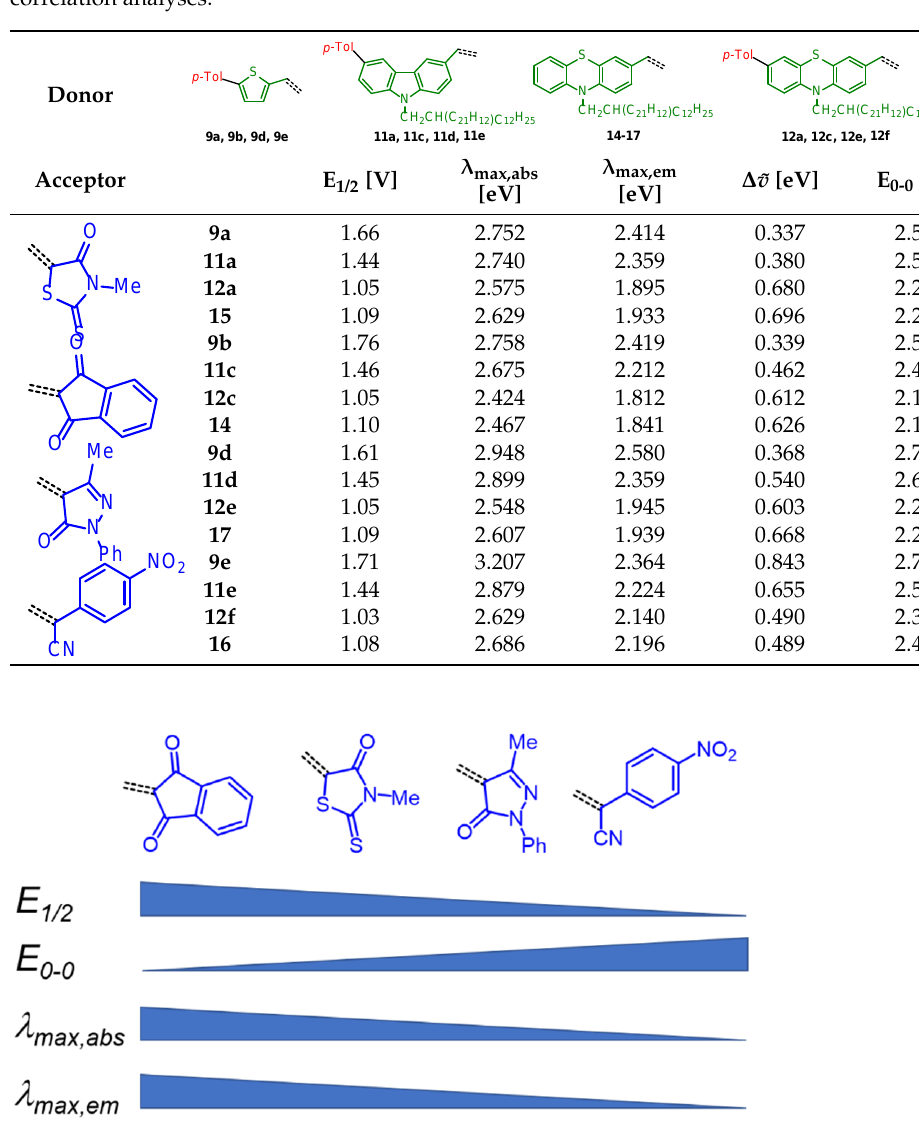
Figure 2. Qualitative acceptor strength decreasing from left to right and their influence on selected electronic data ( E 1/2 , E 0-0 , λ max,abs and λ max,em ). The consanguineous acceptor series of 3-methyl-4-oxo-2-thioxothiazolidin-5-ylidene, 1,3-dioxo-1,3-dihydro-2H-inden-2-ylidene, 3-methyl-5-oxo-1-phenyl-1,5-dihydro-4H-pyrazol- 4-ylidene and cyano(4-nitrophenyl)-methylene derivatives gave good to excellent linear correlations for the plots of λ max,abs , λ max,em , Stokes shift ∆ ˜v and E 0-0 (as energies in eV) against E 1/2 (in Volt) (r 2 > 0.90) (for details on correlation analyses, see Supplementary Material). In particular, the excellent linear correlations (r 2 = 0.943–0.999) between the oxidation potential E 1/2 and the optical band gap E 0-0 (Table 3)) suggest that the electronic ground state property, i.e., oxidation potential, affects the photonic property, i.e., band gap, and could lead to a more general correlation beyond consanguineous chromophore series. Therefore, we expanded the basis of chromophores to a total of 24 (for correlation analyses, see Supplementary Information). An attempt to establish a direct relation between E 1/2 and E 00 gave only a poor linear correlation (r 2 =